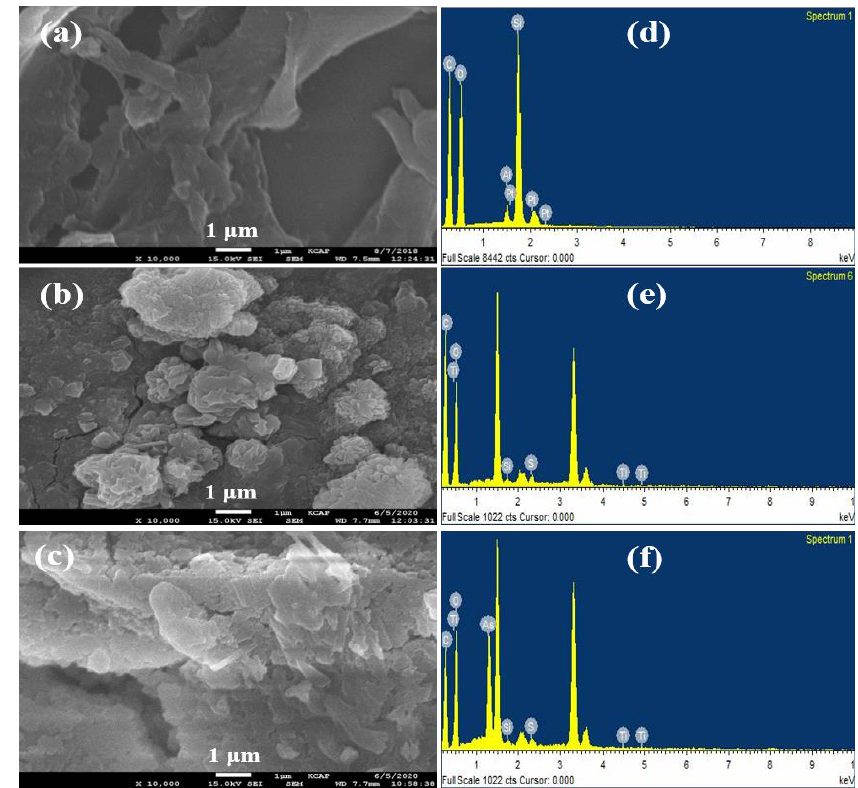
Figure 1. ( a ) SEM image of PP; ( b ) SEM image of PP@TiO 2 ; ( c ) SEM image of As(III) adsorbed PP@TiO 2 ; ( d ) EDS spectra of PP; ( e ) EDS spectra of PP@TiO 2 ; ( f ) EDS spectra of As//PP@TiO 2 .